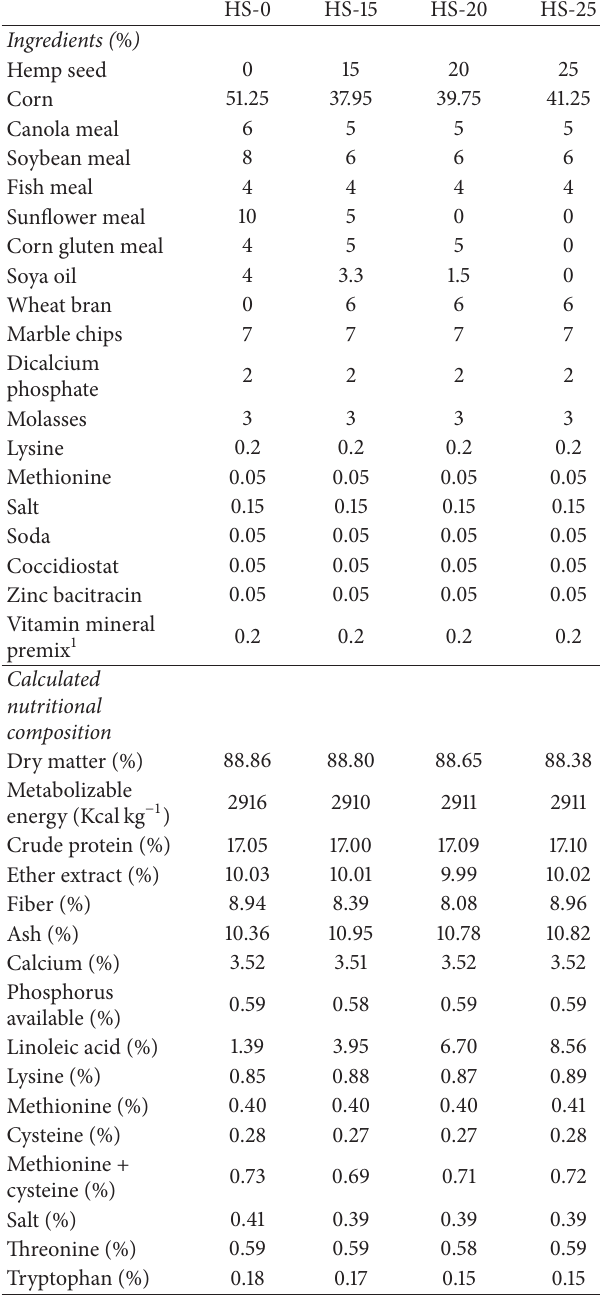
Table 1: Ingredient composition (%) of layer rations with different levels of hemp